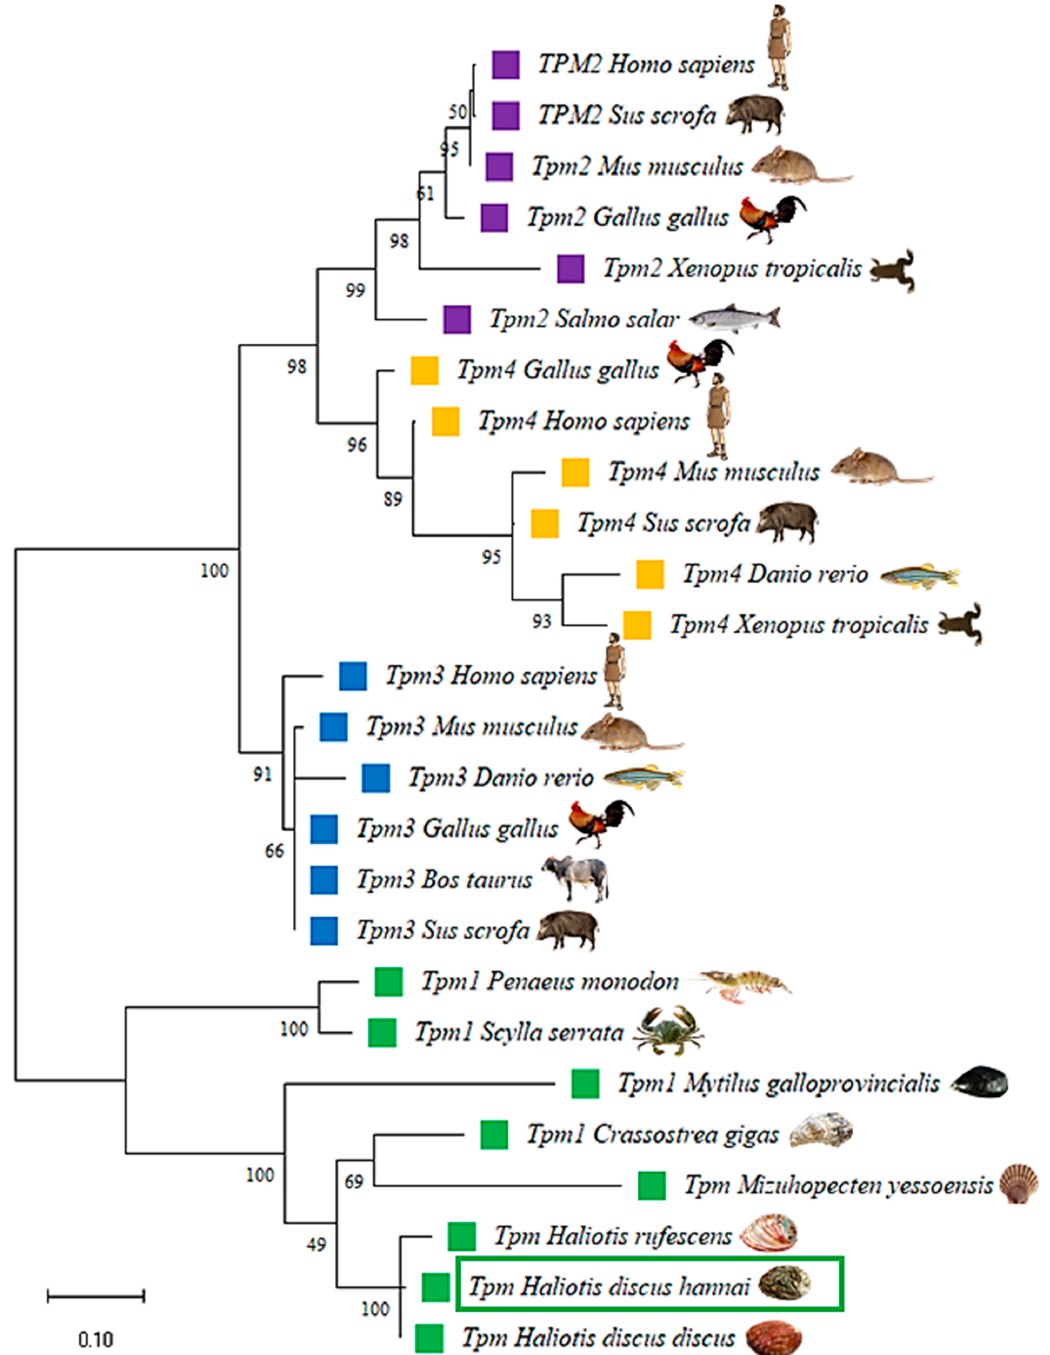
Figure 6. Phylogenetic tree constructed using the maximum likelihood method with a bootstrap value of 1000 after clustalW alignment based on amino acid residues of different isoforms of tropomyosin. The following sequences with their protein ID were used to construct the phylogenetic tree: TPM/TPM1 of H. discus discus (BAH10148.1), H. discus hannai (AAR45321.1), H. rufescens (CAA53028.1), Crassostrea gigus (ARX70262.1), Mizuhopecten yessoensis (BAA20455.1), Mytilus galloprovincialis (VDI44733.1), Scylla serrata (ABS12233.1), and Penaeus monodon (ADV17340.1); TPM3 of Sus scrofa (NP_001001632.1), Bos taurus (NP_001011674.1), Gallus gallus (ATC20309.1), Mus musculus (AAG38596.1), Homo sapiens (ATC20307.1), and Danio rerio (NP_991239.1); TPM4 of Danio rerio (AAH53144.1), Xenopus tropicalis (CAJ82227.1), Sus scrofa (NP_999500.1), Mus musculus (AAH23701.1), Gallus gallus (XP_046789950.1), and Homo sapiens (NP_001138632.1); TPM2 of Danio rerio (XP_005155551.1), Xenopus tropicalis (NP_001025587.1), Gallus gallus (XP_046790843.1), Sus scrofa (NP_001123419.1), Homo sapiens (KAI2552574.1), and Mus musculus